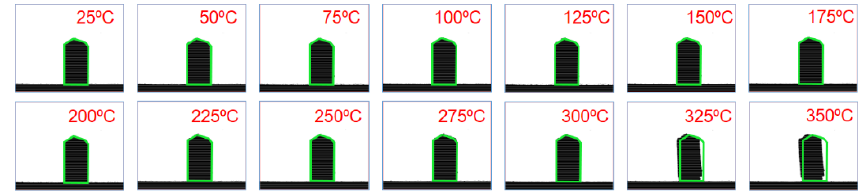
Figure 4. Monitoring of the evolution of the piece’s shape under thermal treatment. (The area marked with the green line corresponds to the original silhouette of the piece before heat treatment in all cases.)